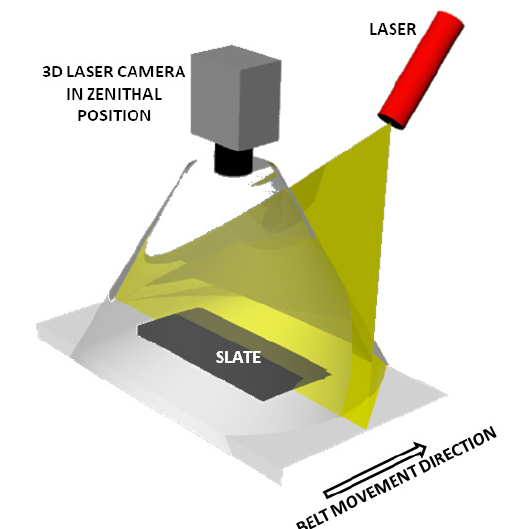
Figure 6. Diagram of the 3D sensing